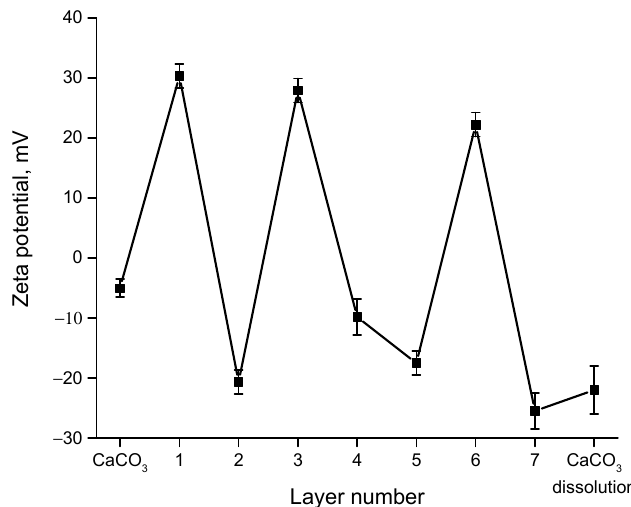
Figure A3. Absorption spectra of a TRITC-dextran.